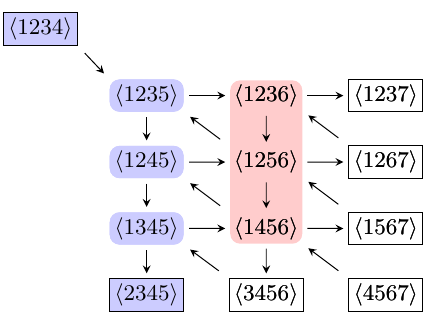
Figure 17. A cluster containing the poles of [12345] in Conf 7 ( P 3 ). The unfrozen nodes highlighted in red generate an A 3 subalgebra by repeated mutation.